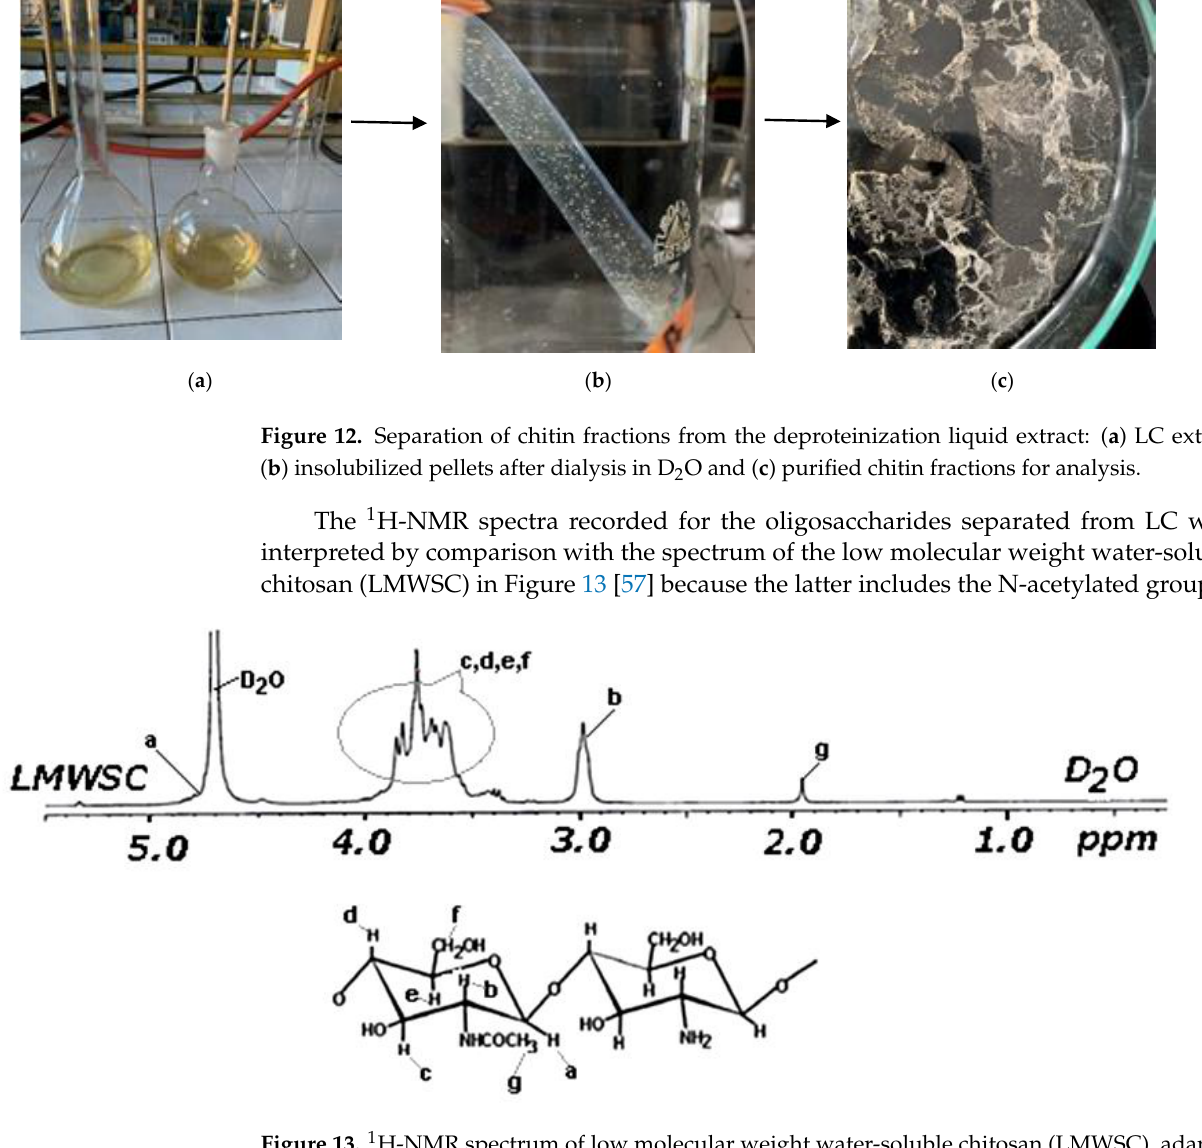
Figure 11. Total protein quantitation using OPA assay: ( a ) Fluorescence emission fitting by using Pseudo-Voigt; ( b ) log-normal distribution functions.